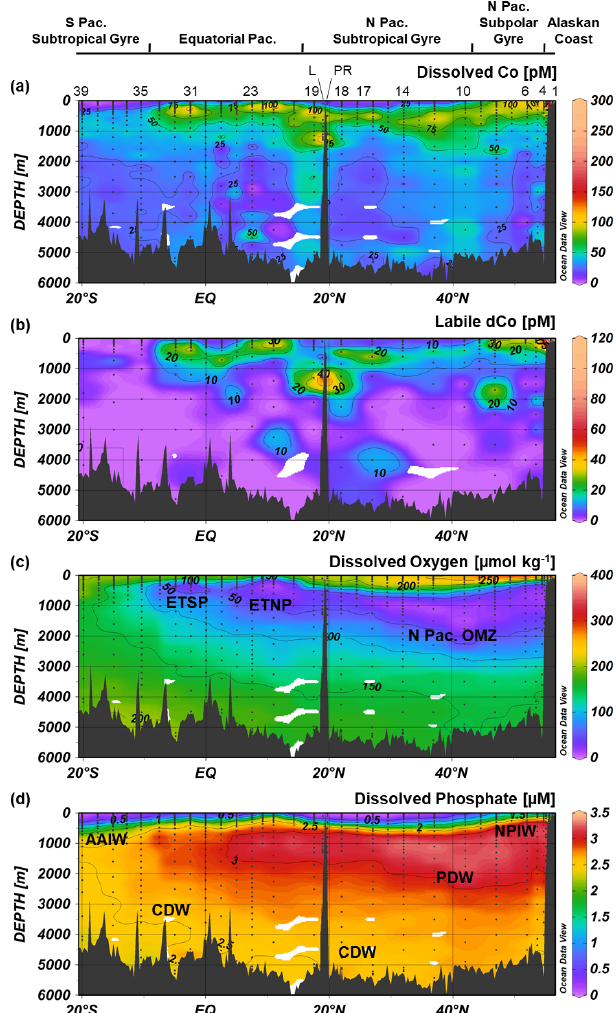
Figure 3. Dissolved Co (a) , labile dissolved Co (b) , dissolved oxy- gen (c) and dissolved phosphate (d) transects along the GP15 cruise track. Select stations numbers are shown in panel (a) , with the Loihi Seamount station labeled as “L” and the Puna Ridge station labeled as “PR”. The eastern tropical North Pacific (ETNP), eastern tropical South Pacific (ETSP) and North Pacific OMZs are labeled, as well as Antarctic Intermediate Water (AAIW), Circumpolar Deep Water (CDW), Pacific Deep Water (PDW) and North Pacific Intermediate Water (NPIW). Weighted-average gridding is used to interpolate be- tween data